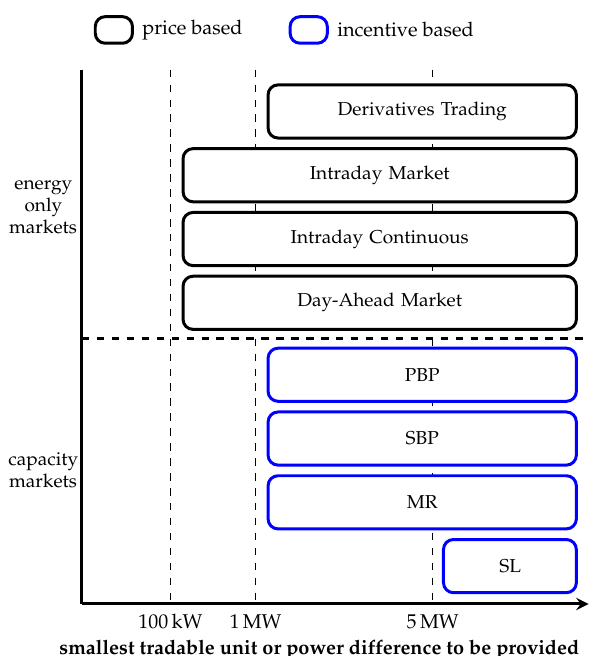
Figure 4. Monetisation options for IDSI depending on the smallest tradeable unit (energy-only markets) or power difference to be provided (capacity markets) (own illustration based on